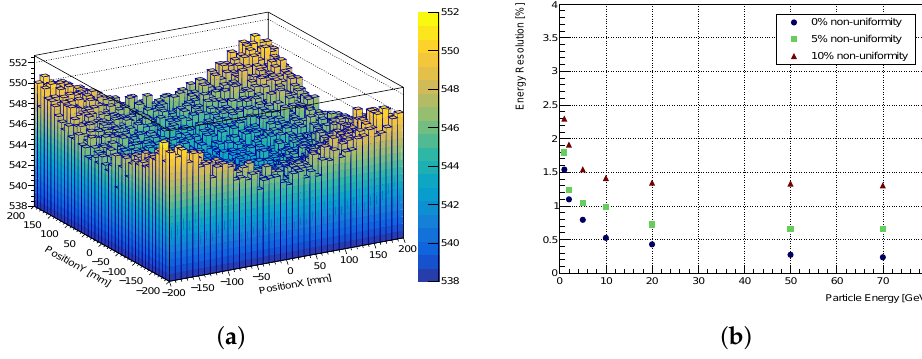
Figure 12. Simulations of uniformity of the crystal ECAL module. ( a ) 2D response uniformity of the ECAL module, 1 GeV muons are used for scanning. ( b ) Energy resolution under certain non- uniformity of long crystal bars. Nine modules are placed in the simulation to prevent energy